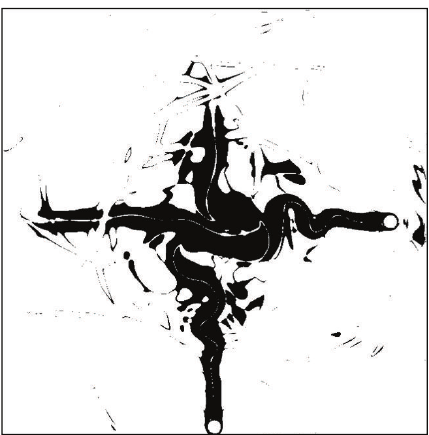
Figure 24: Visualization of switching parameter 𝛽 at t = 23.2 with 𝑑𝑥 = 0.025 𝐷 (white: 𝛽 = 1, black: 𝛽 = 0).